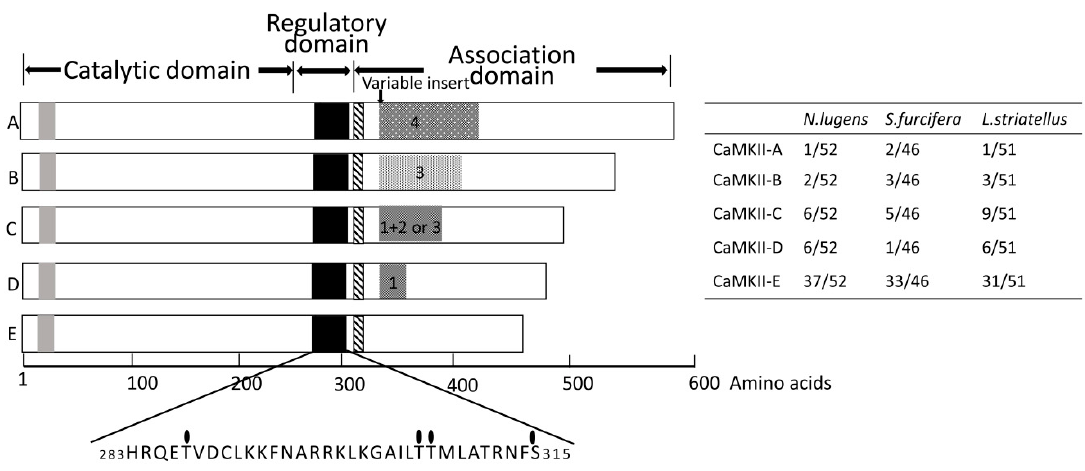
Figure 1. Schematic representation of five main isoforms of the CaMKII polypeptide in three rice planthoppers. The gray-filled box is the putative ATP-binding site. The different dotted boxes show the insertion of amino acid sequences named 1, 2, 3, and 4. The thick shadowed box shows two different (KSG or SKYDVQG) motifs at the beginning of the association domain. The expanded view of the domain structure of the CaMKII sequence indicates the important features of the regulatory domain. The filled ovals show the autophosphorylation sites within the regulatory region that prevent the re-binding of Ca 2+ /CaM. The numbers of clones of each isoform with respect to the total number of isolated clones are given in the table on the right.